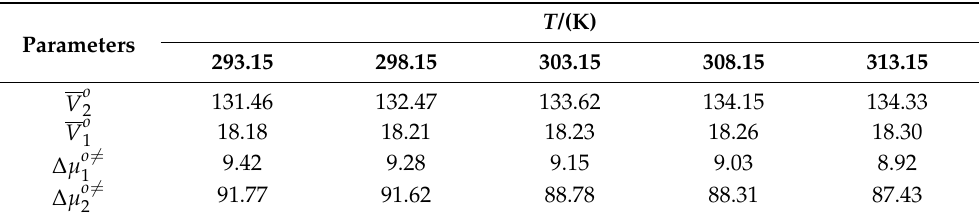
, and ∆ µ o (cid:54) = of viscous flow values of caffeine 2 1